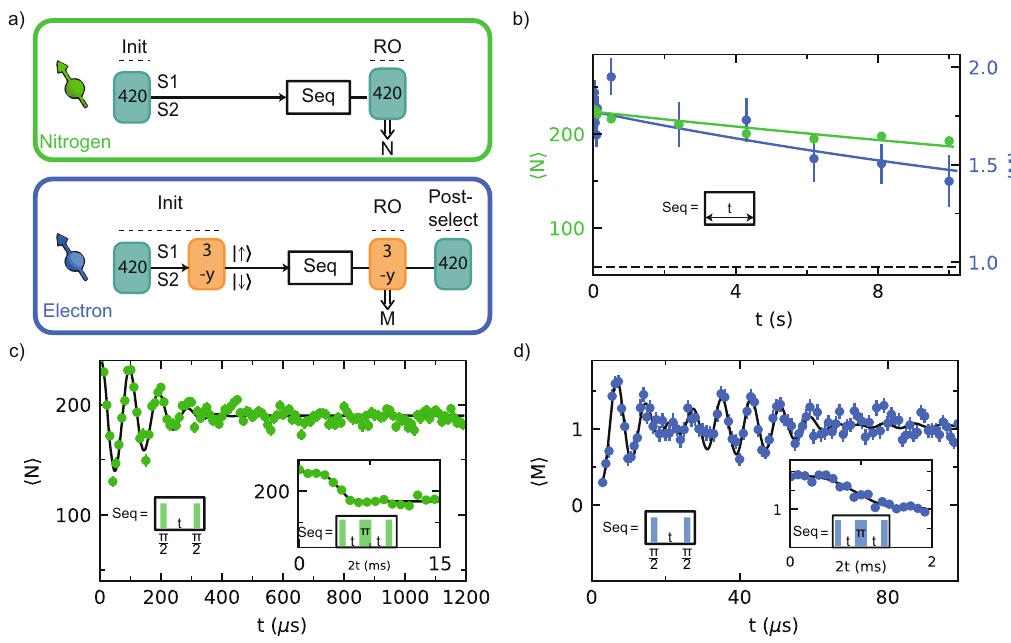
Fig. 5 Coherence and timescales. a Sequence for initialization of either S1 or S2 in þ 1 ; D j i (top). Sequence for initializing all degrees of freedom of either S1 or S2, including the electron spin state (bottom). These sequences are used in b – d . b Relaxation of a combination of: the nitrogen nuclear spin state, JT axis, and charge state (green), and only the electron spin state (blue). We fi t (solid lines) both curves to o + A 0 e − t / T , where o is fi xed to the uninitialized mean value (dashed line) and obtain T = T þ 1 ; D j i = 40(4) s and T = T 1 = 21(7) s. c Ramsey experiment on the nitrogen nuclear spin. We fi t the data (solid = 0.201(9) ms. (inset) Nitrogen nuclear spin-echo experiment. From the fi t we obtain T = 4.2(2) ms. d Ramsey experiment on the line) and obtain T (cid:3) 2N 2N = 50(3) μ s) with a single beating is observed, suggesting a dipolar coupling between S1 and S2. (inset) Electron spin- electron spin. A Gaussian decay ( T (cid:3) 2 e echo experiment. From the fi t we obtain T 2e = 1.00(4) ms. See “ Methods ” for complete fi t functions and obtained parameters. All error bars indicate one statistical standard